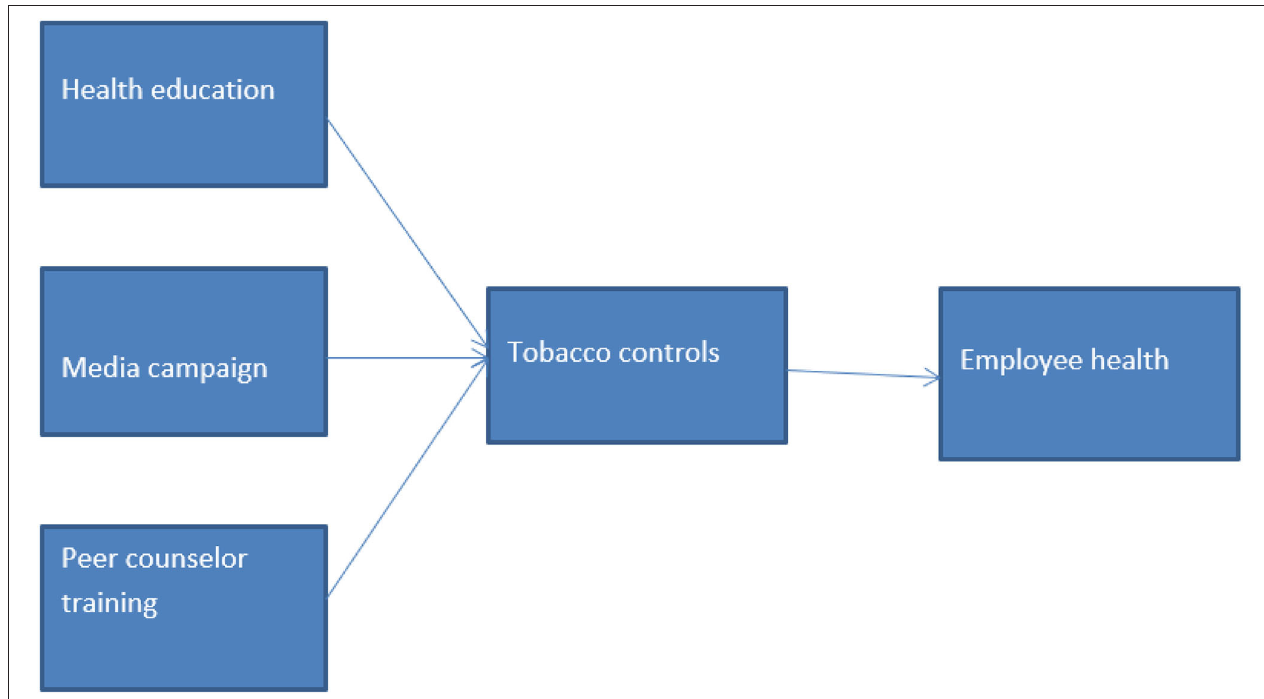
FIGURE 1 | Conceptual